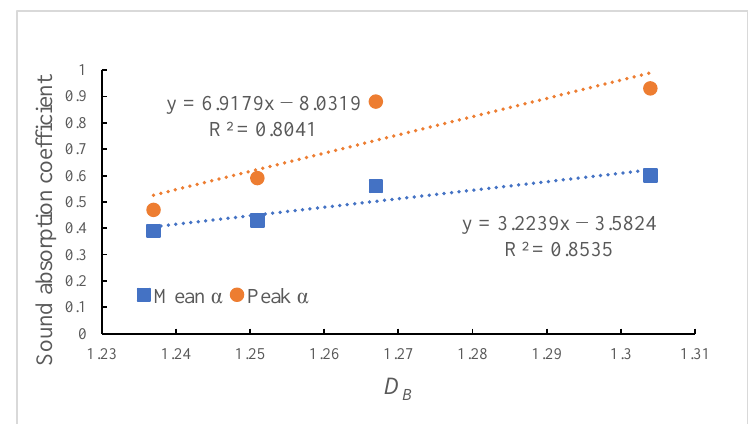
Figure 8. Relationship between the SAC and 𝐷 𝐵 .